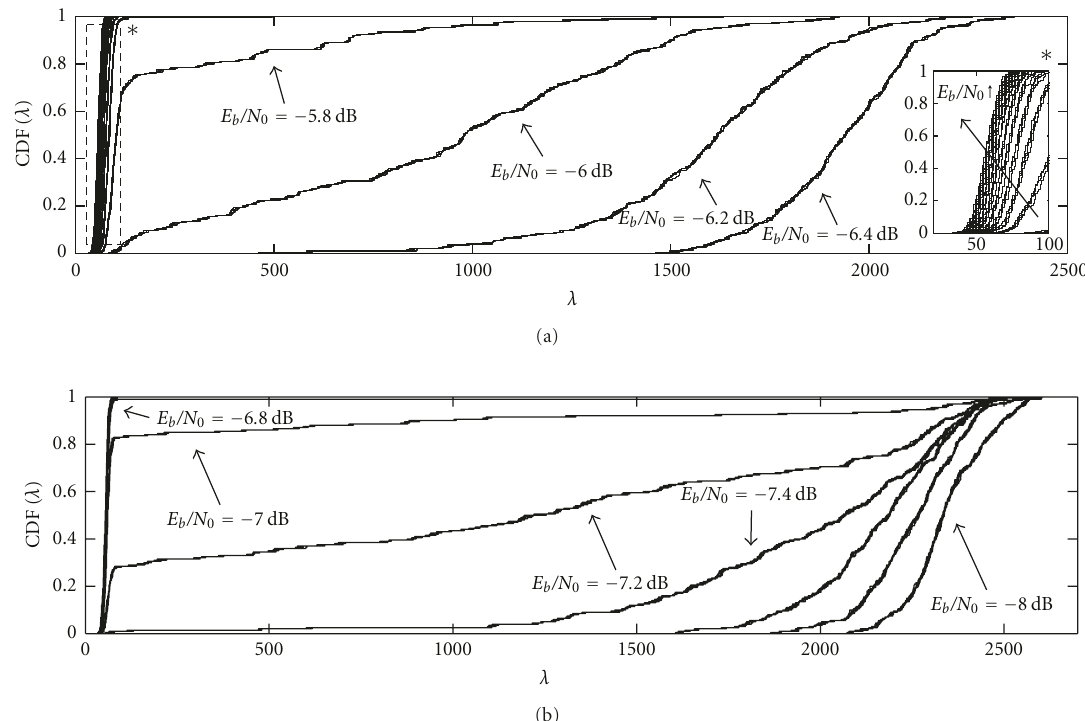
Figure 5: Cumulative Density Function CDF( λ ) versus number of errors per LDGM-decoded block λ for (a) N = 4 sensors and [ d c d v ] = [10 5]; (b) N = 6 sensors and [ d c d v ] = [12